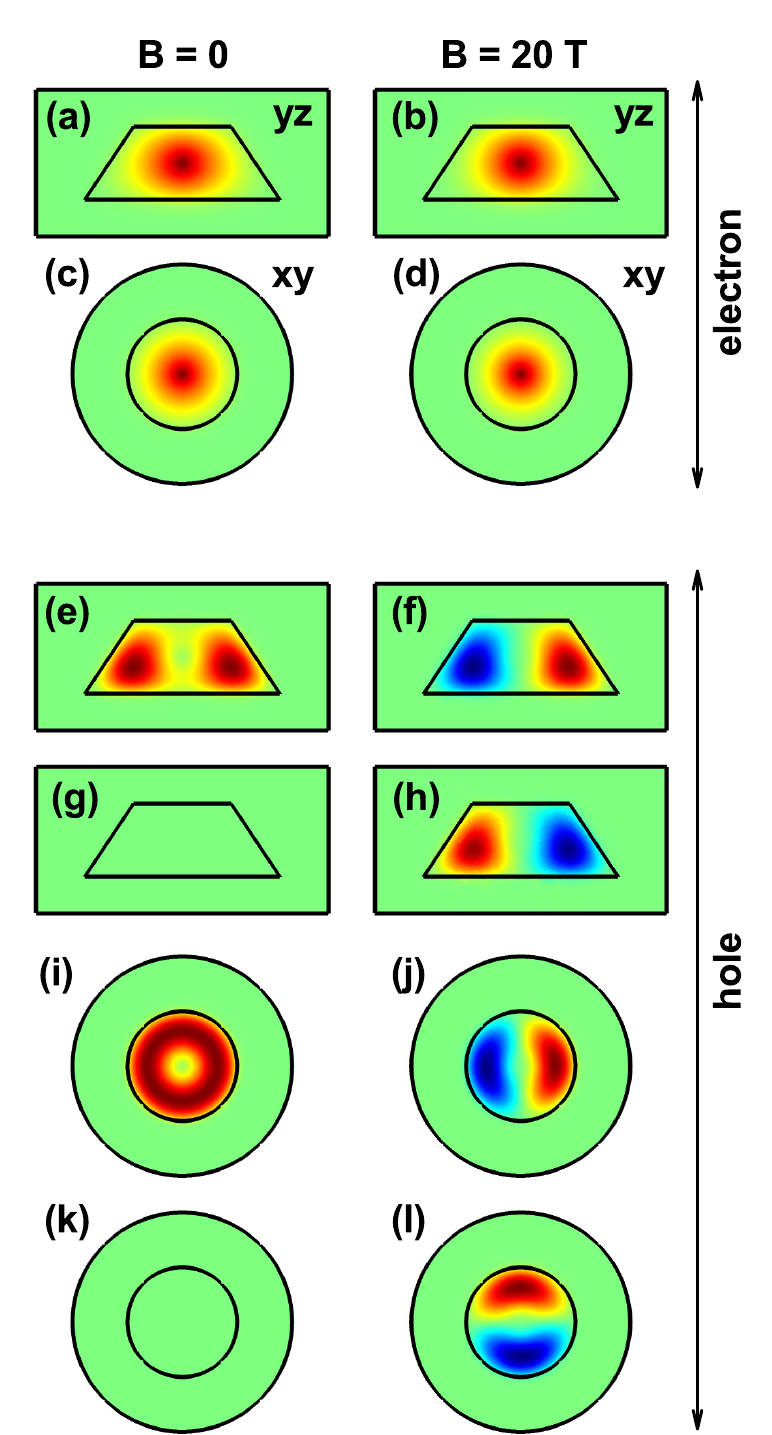
Figure 4. The x = 0 ( a , b , e – h ) and z = 7.5 nm ( c , d , i – l ) projections of the electron and heavy hole ground state wavefunctions (WF) in a truncated conical-shaped GaAs-Al 0.3 Ga 0.7 As quantum dot, for two values of the vertically applied magnetic field (each column corresponds to a fixed value of the magnetic field). The first two rows are for the real part of the electron WF, rows 3 and 5 are for the real part of the hole WF, whereas rows 4 and 6 are for the imaginary part of the hole WF. Calculations are for R 1 = 10nm, R 2 = 20nm, h = 15nm, and with a donor impurity located at z i =